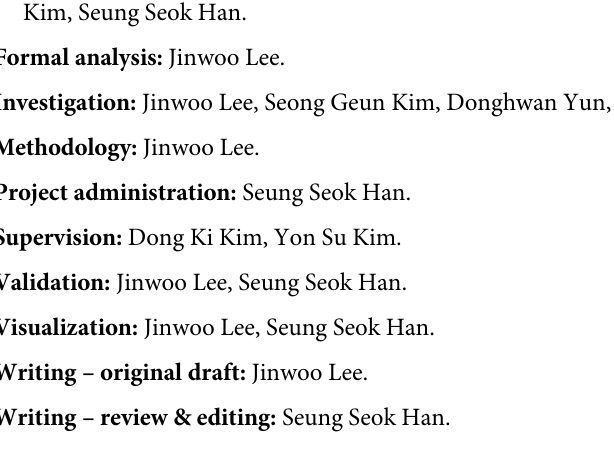
S2 Table. Baseline patient characteristics after extreme gradient boosting model with inverse probability treatment weighting-based propensity score matching. S3 Table. Mortality outcomes in all